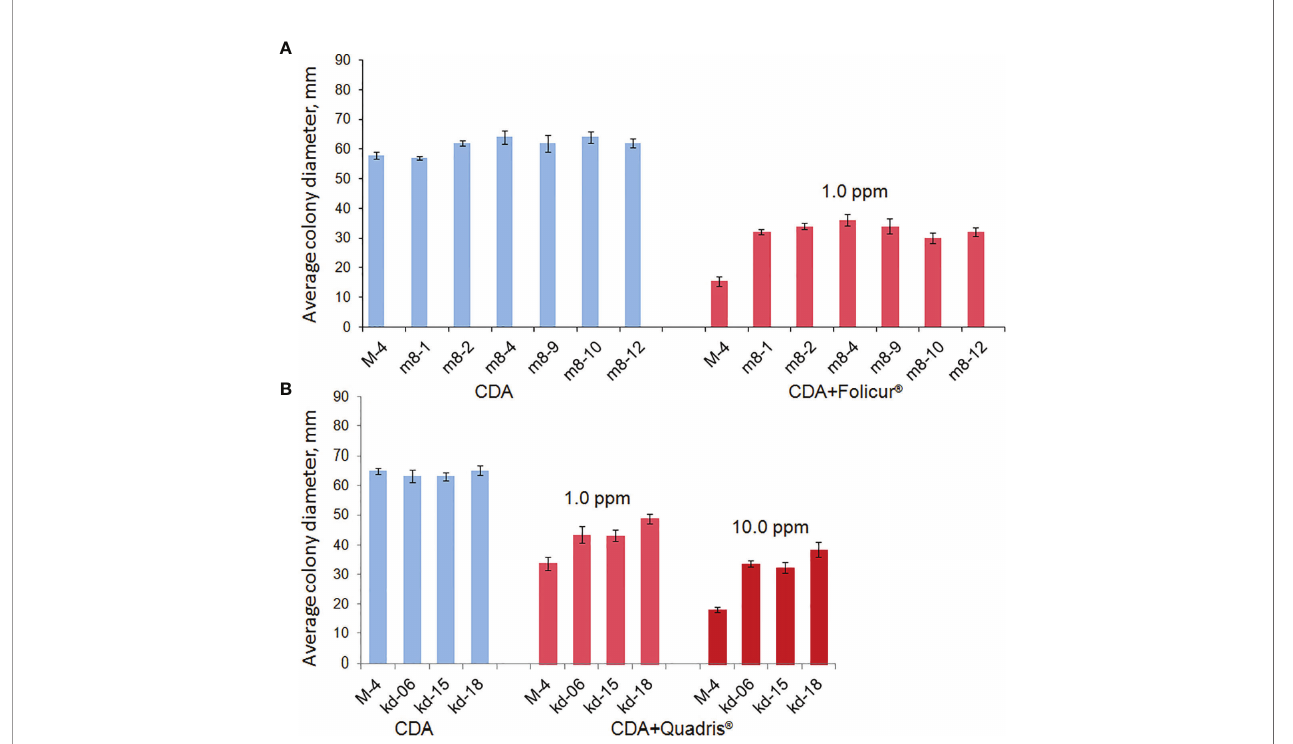
FIGURE 1 | Rates of radial growth of P. nodorum wild strain (M-4) and mutants (m8-2, m8-4, m8-9, m8-10, and m8-12) resistant to Folicur ® or Quadris ® on Czapek Dox agar (CDA) and CDA supplemented with fungicides. Mean colony diameters were calculated after measuring the diameters of each 7-day colony in two perpendicular directions (3 colonies per treatment in each of the thrice-repeated experiments). Columns indicate the mean of three experiments, six replications per strain. Y-bars show